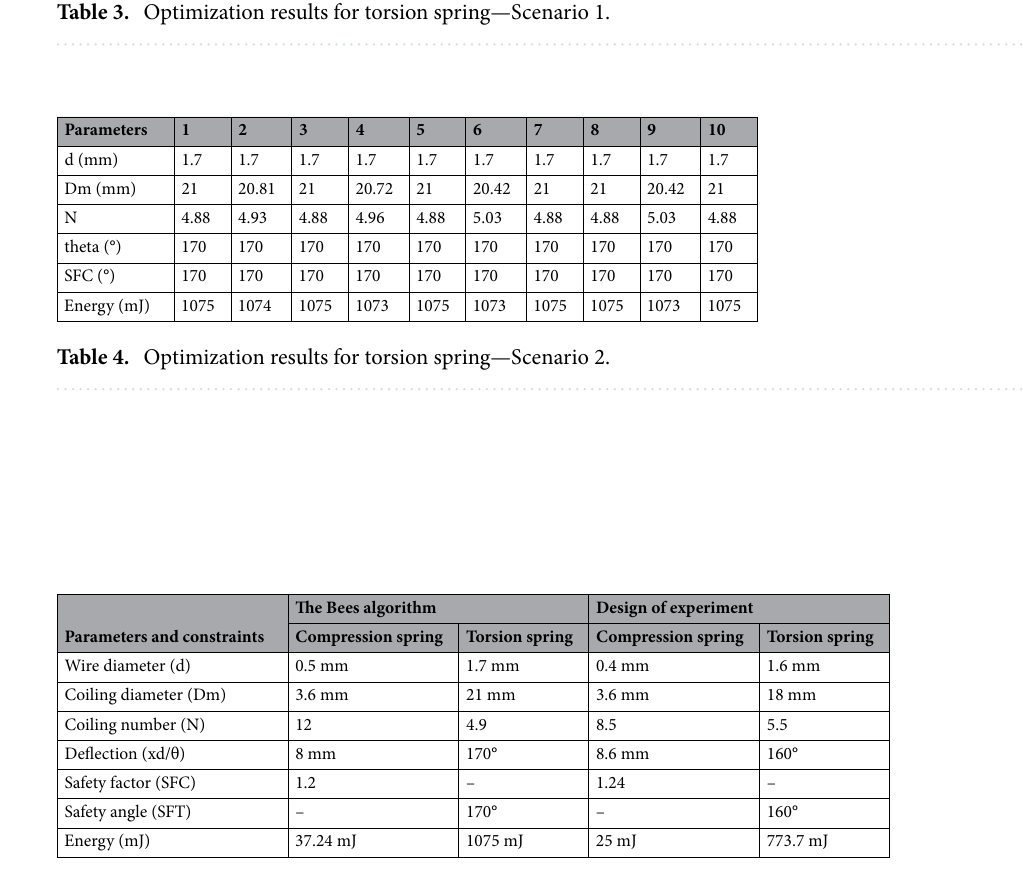
Table 5. Parameters of compression and torsion springs